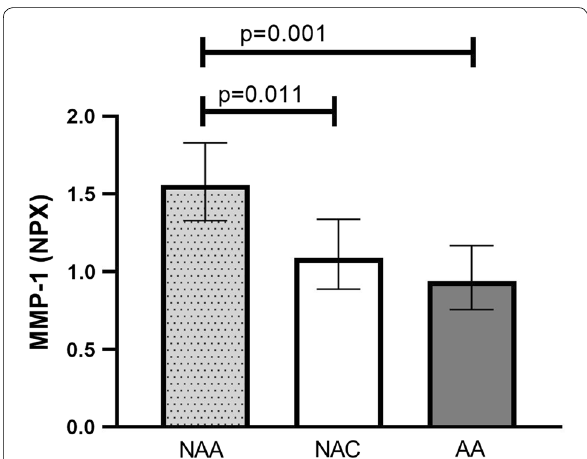
Fig. 2 Plasma levels of MMP-1 in the included study groups. Geometric mean (95%